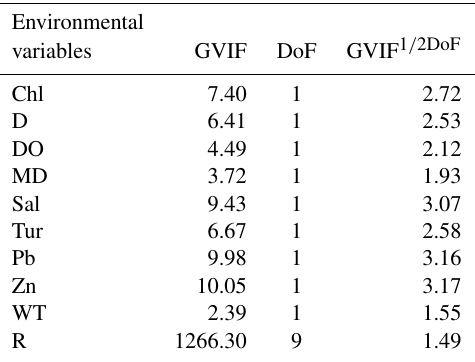
Table 4. GVIF value for environmental variables. DoF, degrees of freedom; R, region. Other abbreviations are found in Table